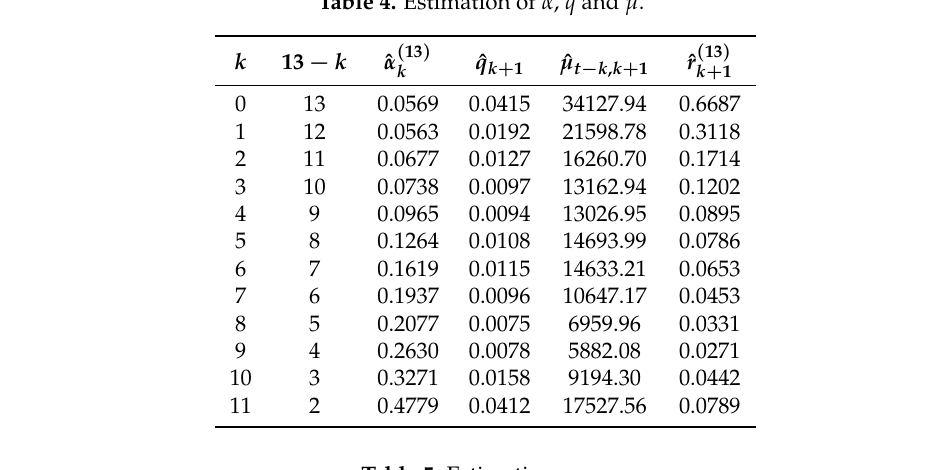
Table 5. Estimation s ( i ∗ )